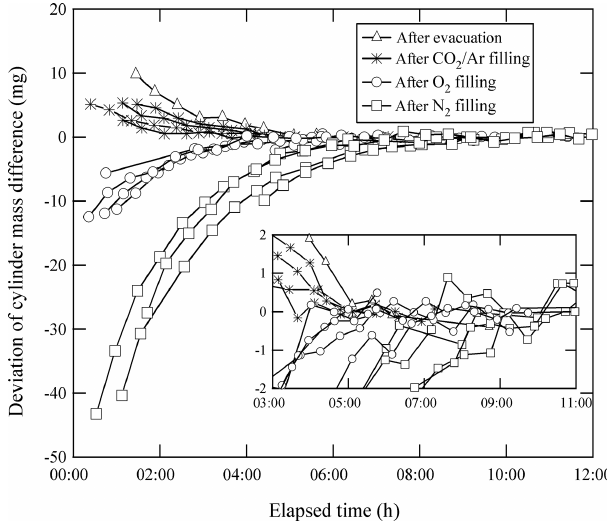
Figure 1. Changes in mass readings of sample cylinders plotted against the time elapsed after evacuation of the cylinder and fill- ing of source gases. The mass readings were obtained using the weighing system. Deviation of the mass reading is expressed as the change in amount from the equilibrium value, which was defined as the mass reading when the standard deviation of the values re- mained constant for 2 or more